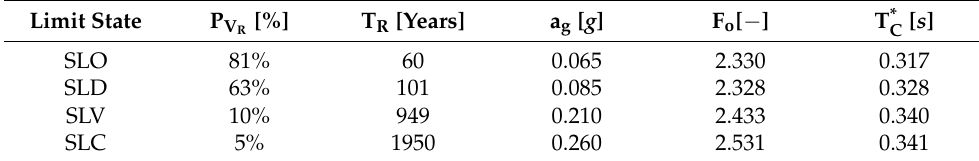
Table 6. Main parameters of the seismic hazard based on the limit states. Limit